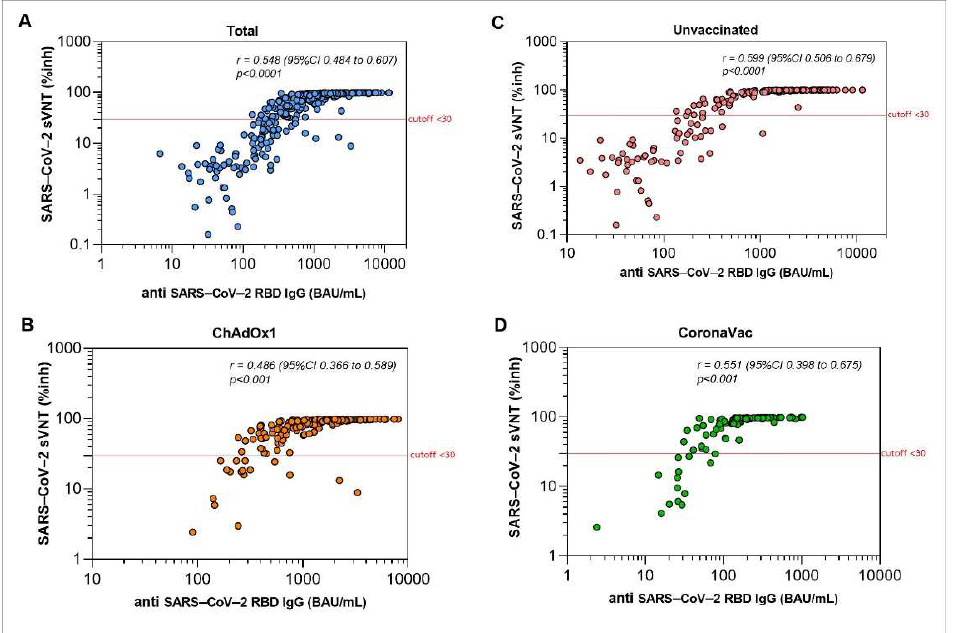
Figure 6. Immune responses after breakthrough COVID-19 infection with prior CoronaVac or ChAdOx1 vaccination during the Delta pandemic. Dot plots show the correlation between the level of anti-SARS-CoV-2 RBD IgG and surrogate viral neutralization test (sVNT) for the SARS-CoV-2 delta variant in plasma of study participants (total, ( A ) who were unvaccinated ( C ), or completed two doses of ChAdOxX1 ( B ), CoronaVac ( D ) and had breakthrough infection.